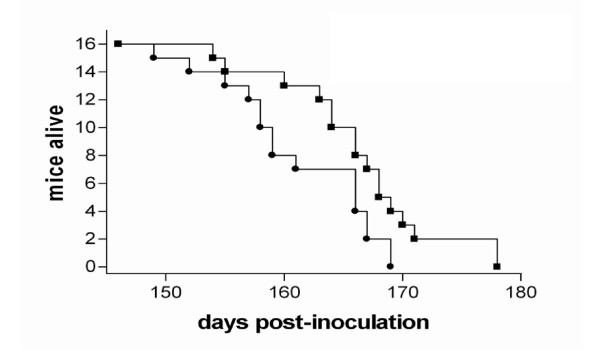
Survival of scrapie infected mice. Survival times after intracerebrally injection of scrapie ME7-derived brain homogenate (10% w/v in sterile saline) of mice treated with IL-12 and IL-18 (circles) or with saline (squares).